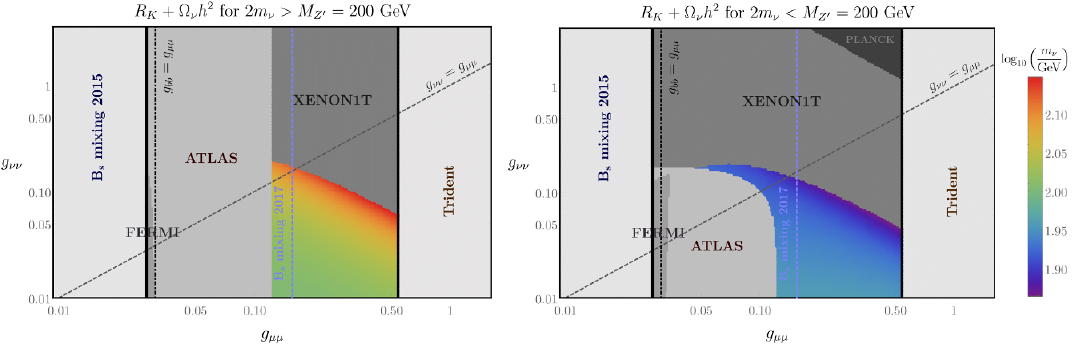
Figure 6 . Summary of the constraints for M Z 0 = 50 GeV. See text in section 5 for details.